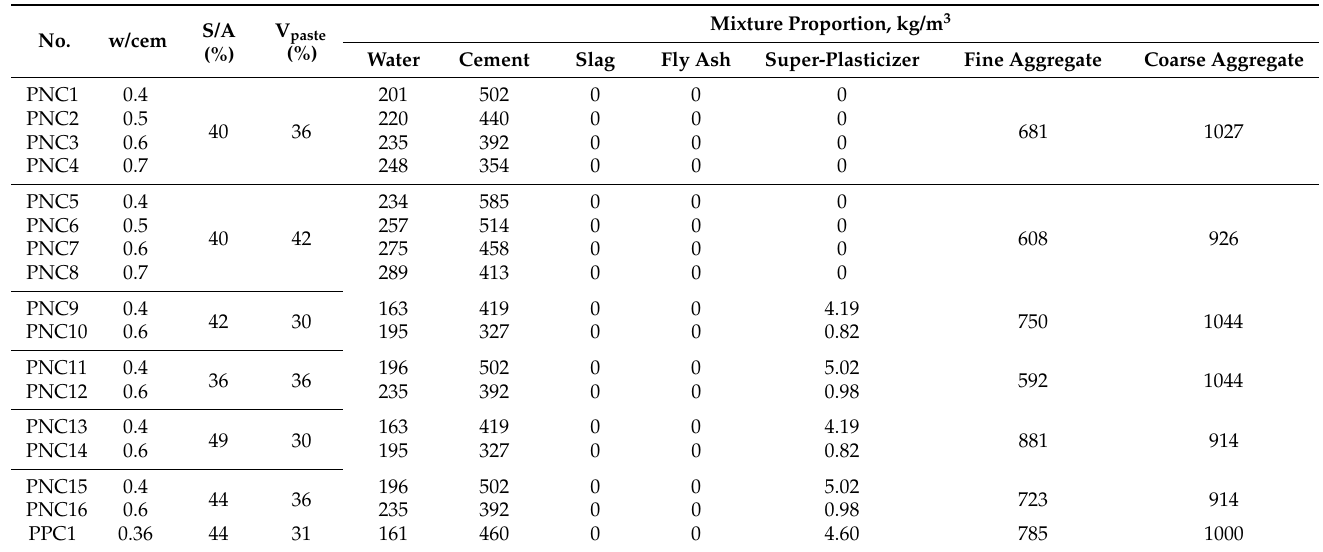
Table 7. Normal concrete mixture proportions collected from the relevant studies for verifying the applicability of the unified equation.